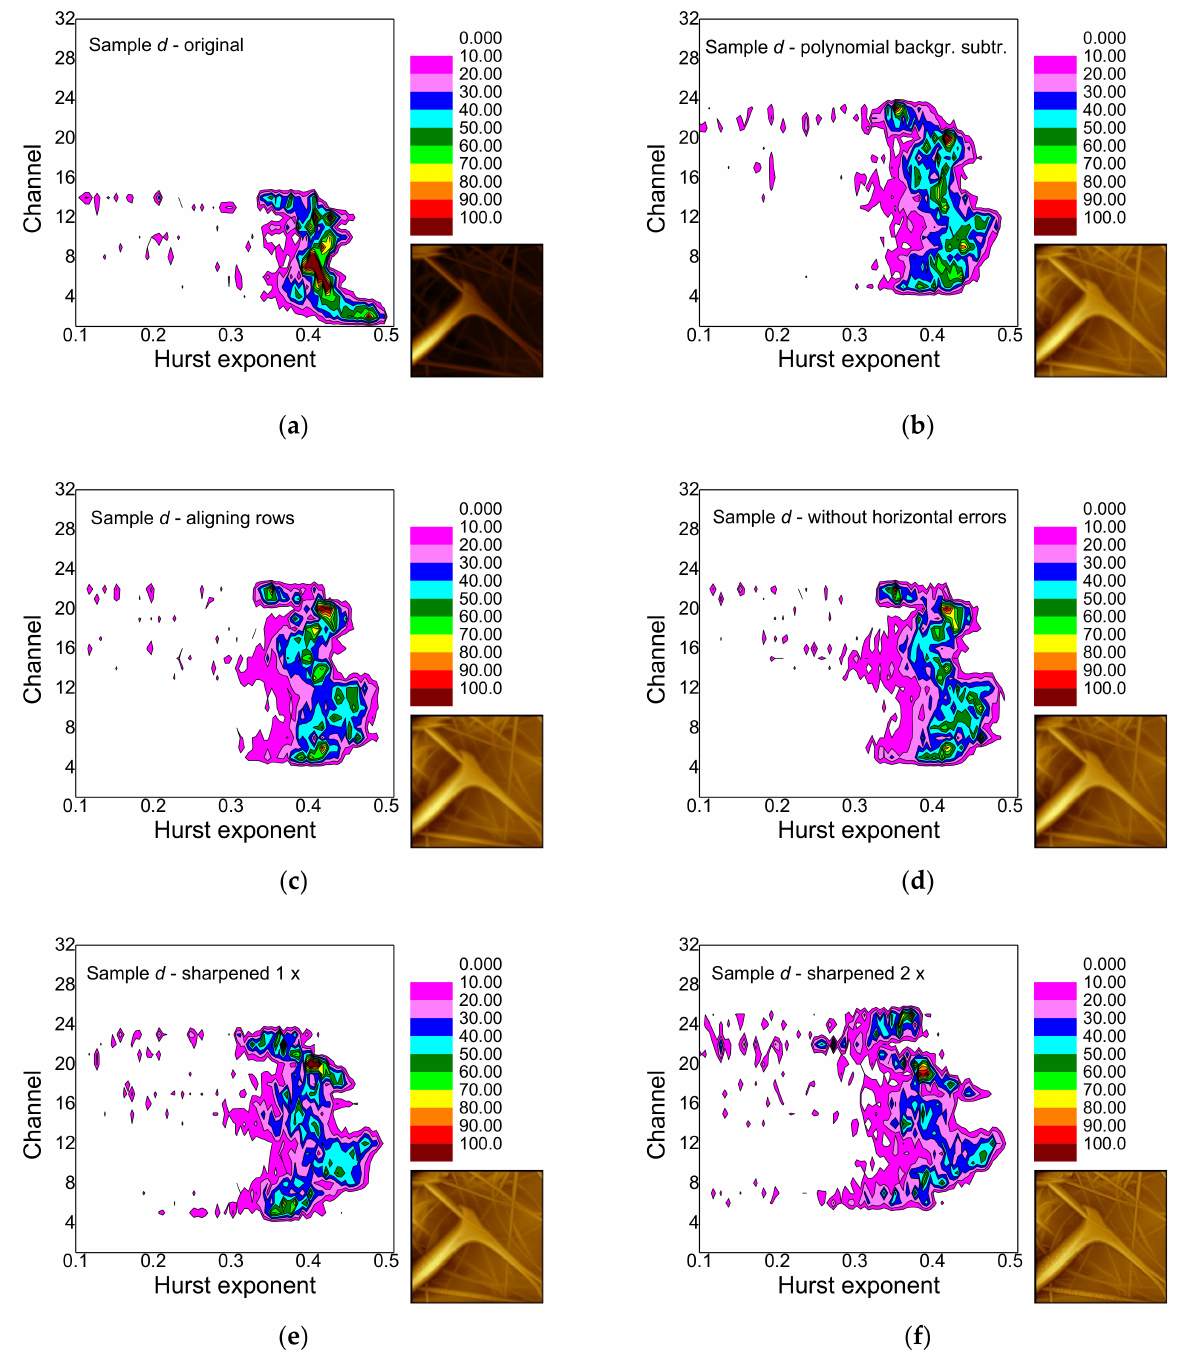
Figure 9. Gray-scale-resolved Hurst exponent distribution of sample c : ( a ) original; ( b ) after polynomial background subtraction; ( c ) after aligning rows; ( d ) after deleting horizontal errors; ( e ) after sharpening; ( f ) after sharpening